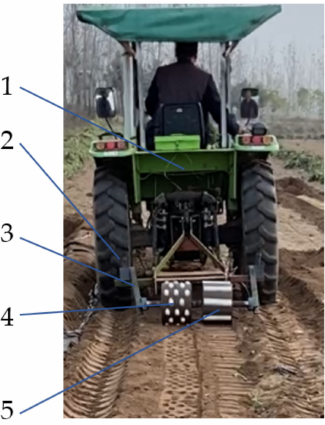
Figure 12. The scenario of verification test. 1. low-power tractor; 2. pressure control system; 3. profile control frame; 4. bionic convex press roller; 5. bionic ridged press